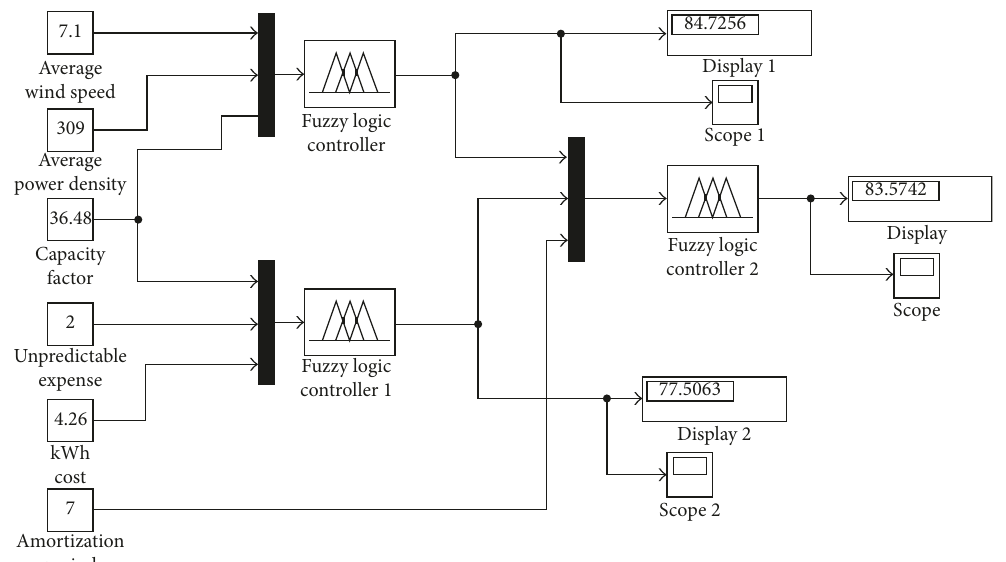
Figure 10: Display of the result values generated by the fuzzy-based decision-making system designed according to the input values calculated by the